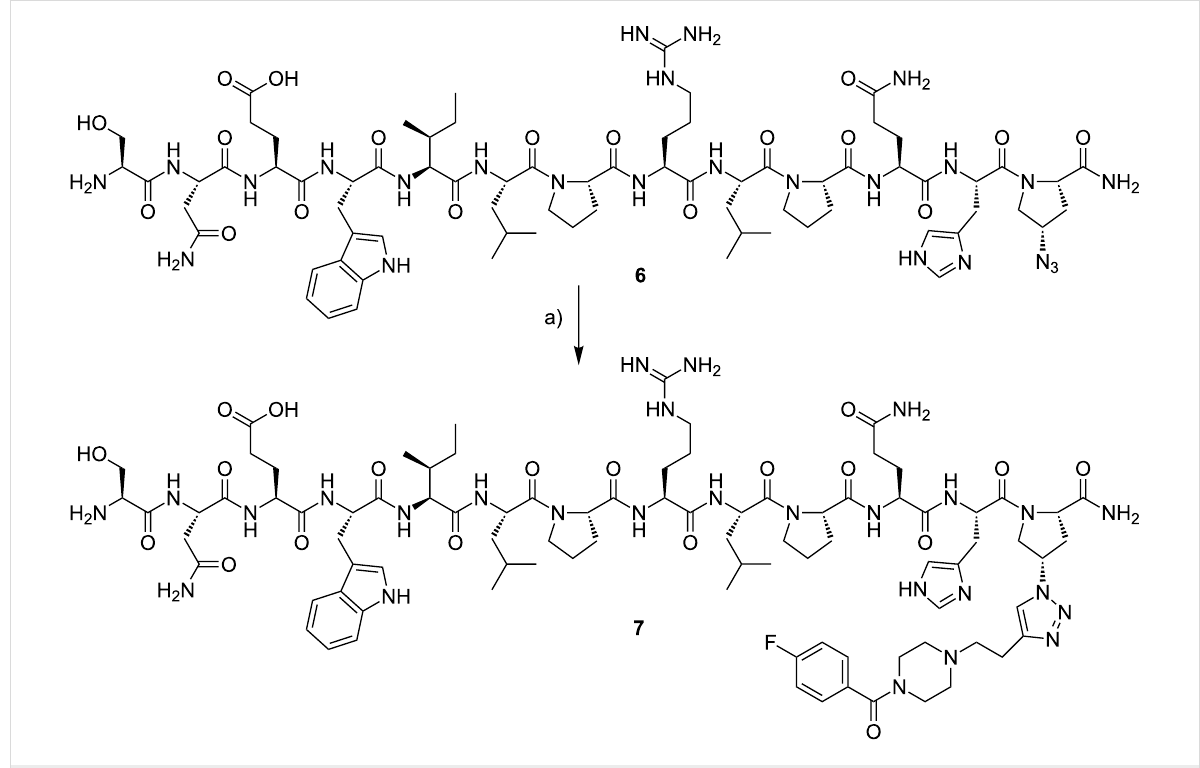
Scheme 2: Peptide labeling using the Huisgen-click reaction and building block 4b . Reagents and conditions: a) 4b , CuSO 4 , Na ascorbate, PBS buffer (pH 7.4), 40 °C, 16 h.